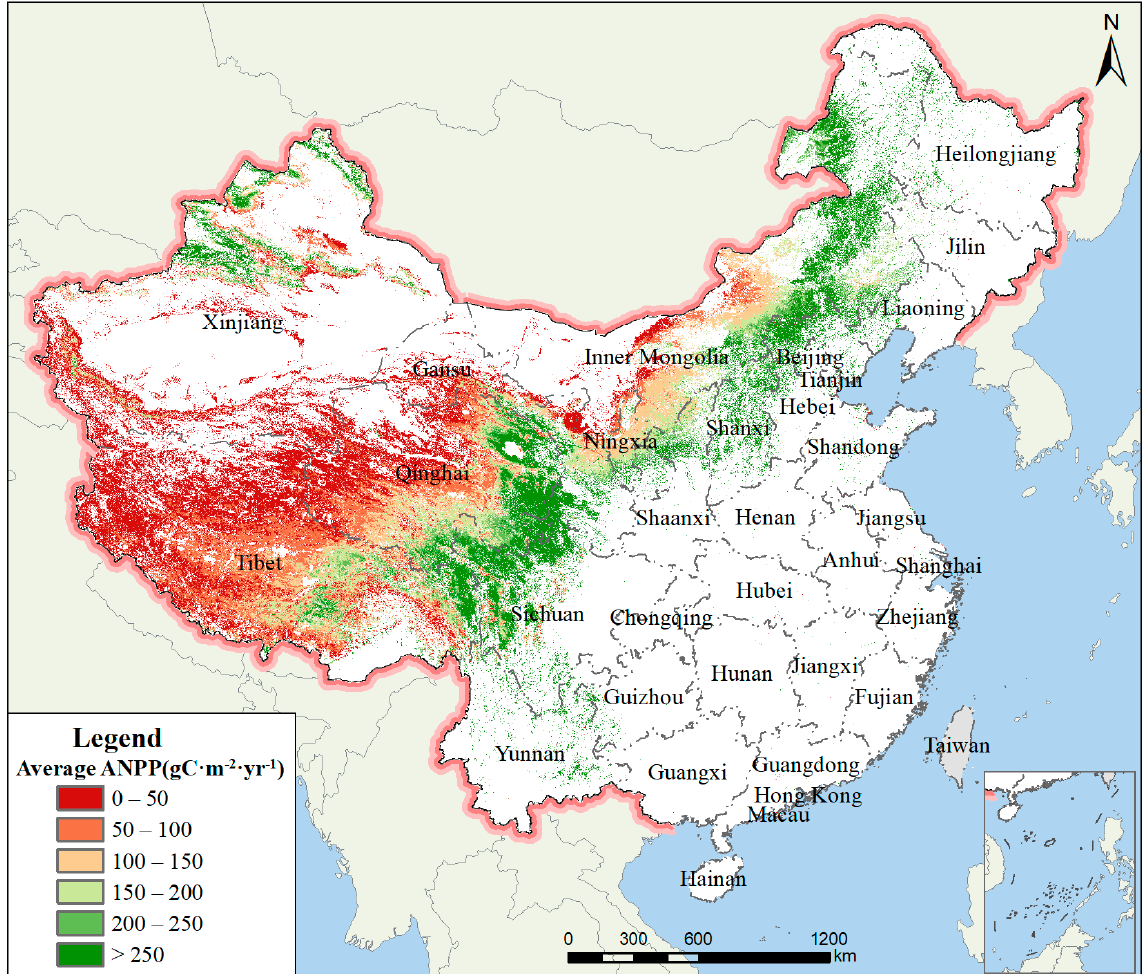
Figure 5. Spatial distribution of annual mean ANPP (2001–2020).